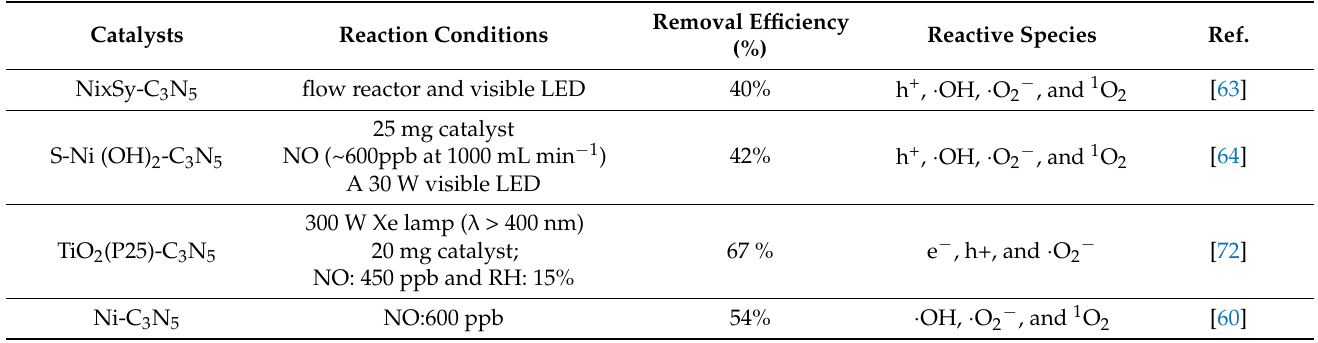
Table 2. Summary of applications in photocatalytic NO removal using g-C 3 N 5 -based materials.